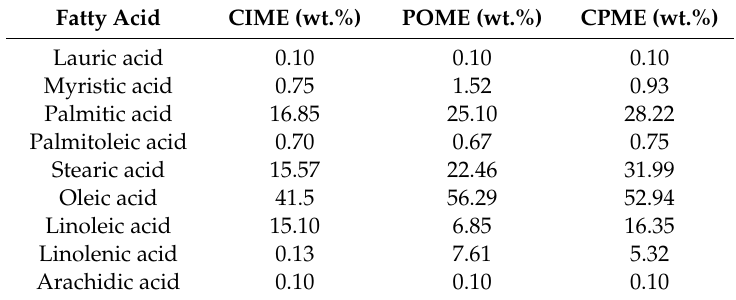
Table 4. Fatty Acid Methyl Ester (FAME) composition of Calophyllym inophyllum Methyl ester, CIME,